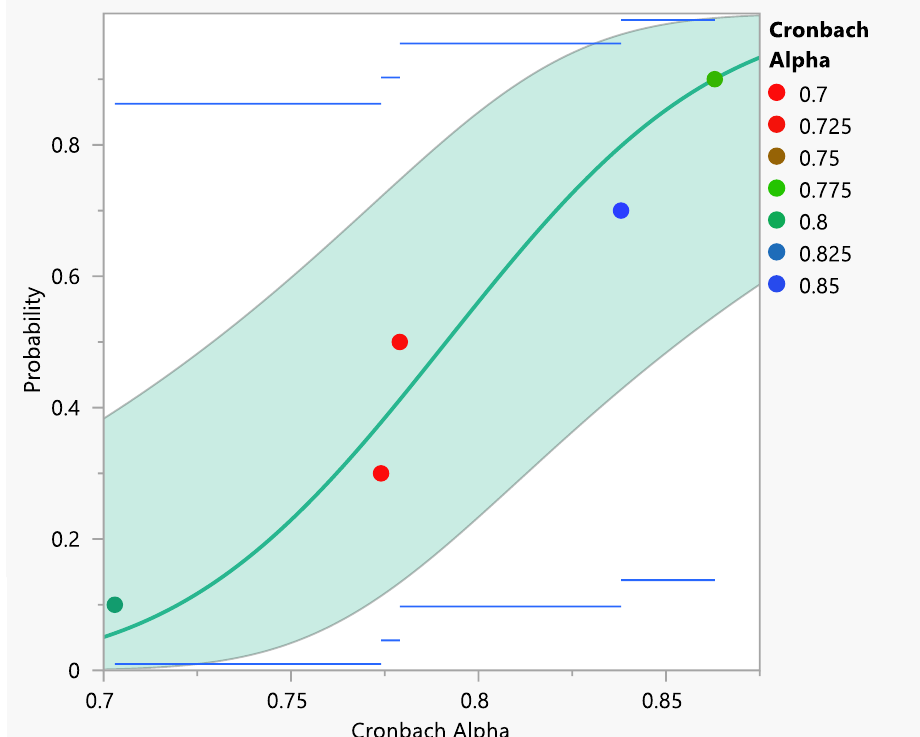
Figure 5. Normal probability curve of Cronbach alpha.